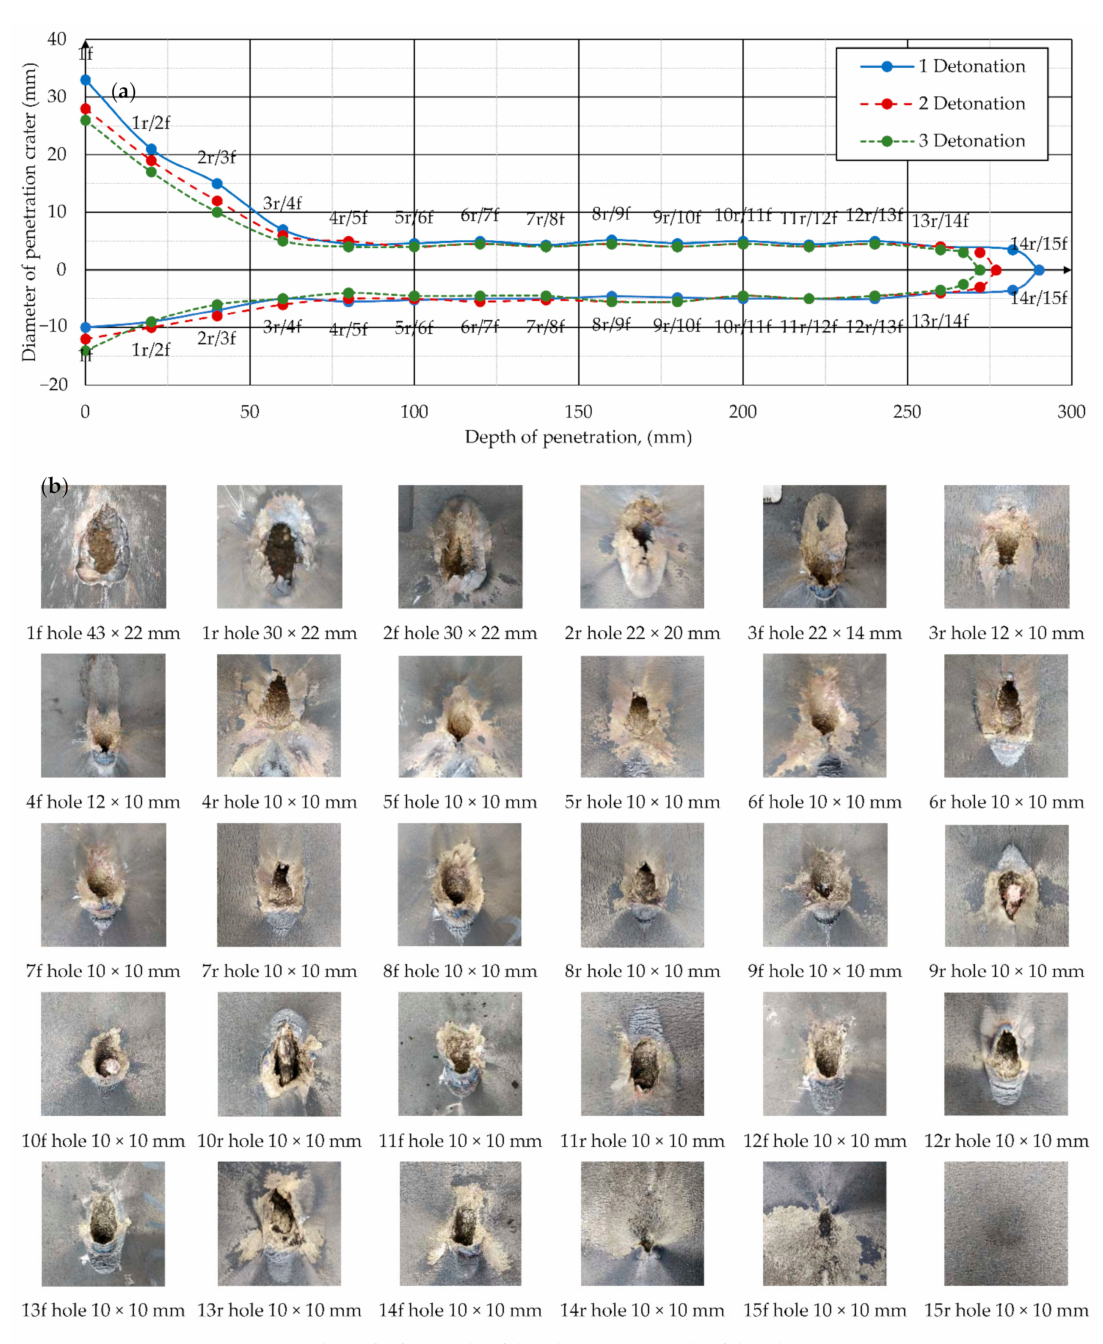
Figure 10. Results of DoP tests: ( a ) shapes of longitudinal cross-section of the penetration craters in the stack of ARMSTAL 30PM armored steel plates calculated on the basis of three experimental trials; ( b ) shapes of the inlet and outlet holes in the armor plates observed after the PG-7VM warhead detonation (2